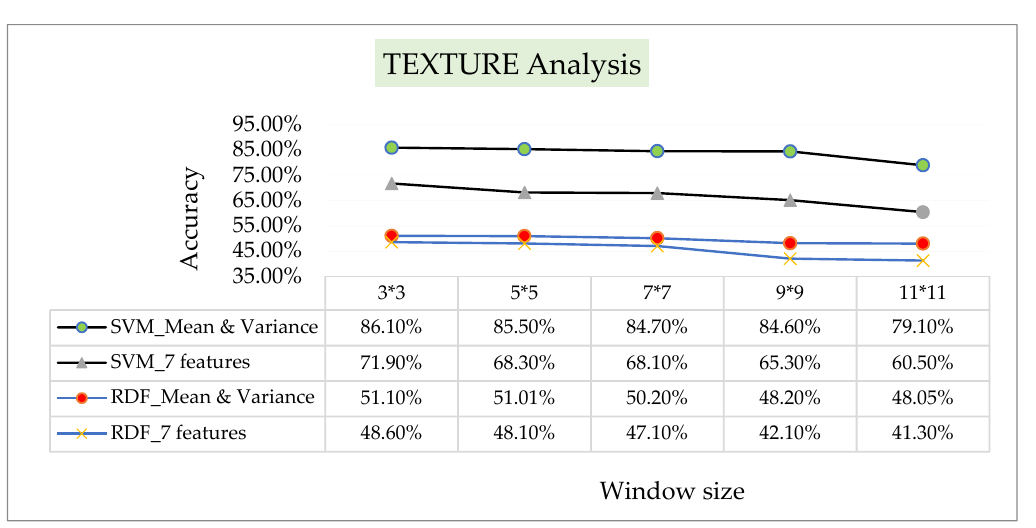
Figure 8. The Architectural Institute of Japan scale (AIJ) [15,33]. In the last part of the study, the values of the above three methods were combined. The results showed that the TD and CD, despite their good capabilities, led to poorer results in this evaluation in combination with the ELD (Table 3).